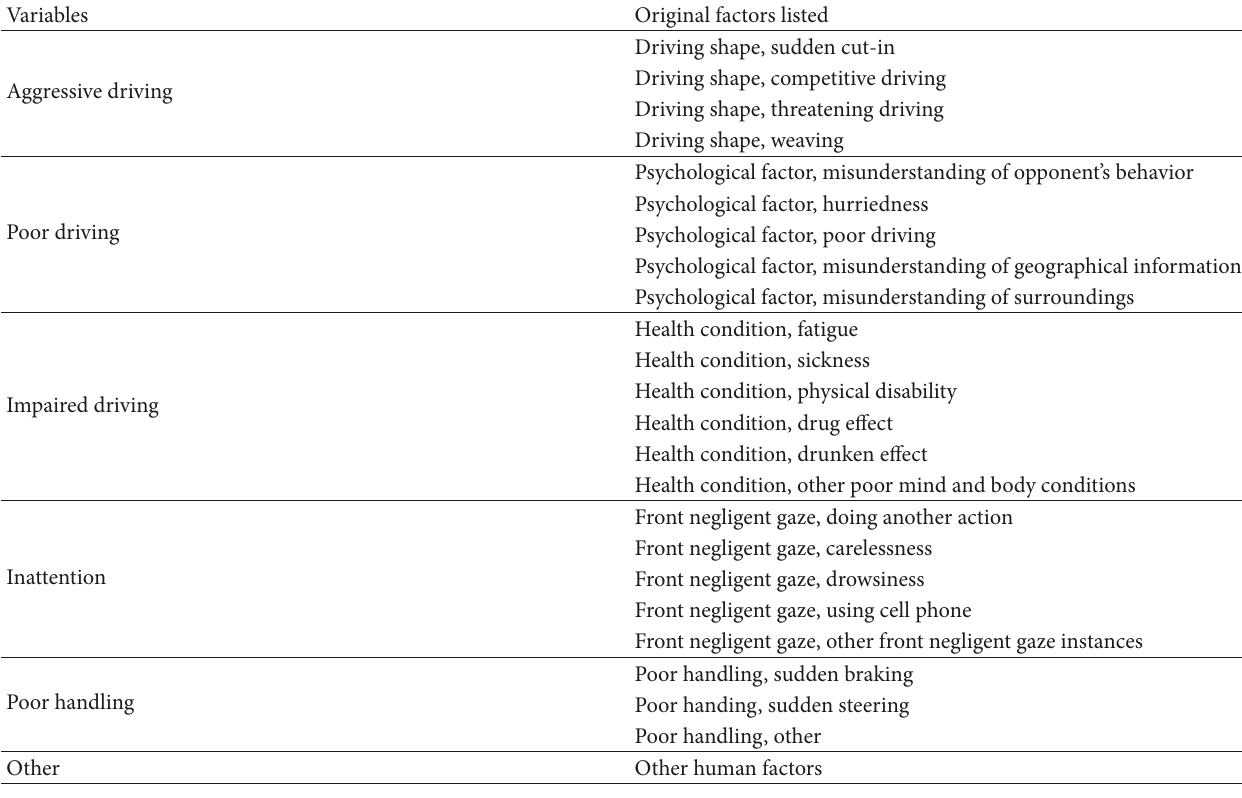
Table 1: Human related contributing